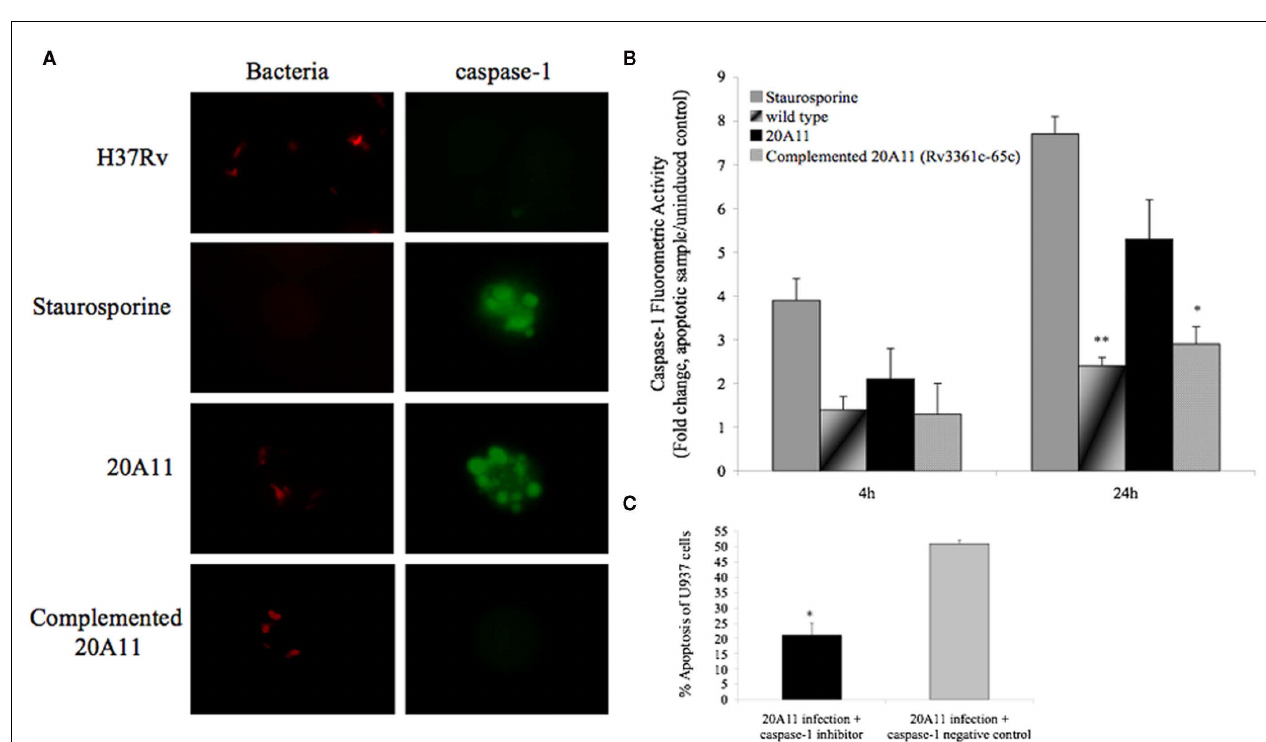
experiments ± SD. * p < 0.05 And ** p < 0.01 statistically significant differences between complemented 20A11 and wild-type infection versus 20A11 mutant after 24h post-infection, respectively. Active caspase-1 was quantified in situ using FAM–YVAD–FMK caspase-1 detection assay (Bachem). (C) Apoptosis level in caspase-1 inhibited macrophages after 24h of 21A11 mutant post-infection examined byTUNEL.The values are means ± SD of two separate experiments performed in duplicate.The significance of differences between caspase-1 inhibitor and the caspase-1 negative